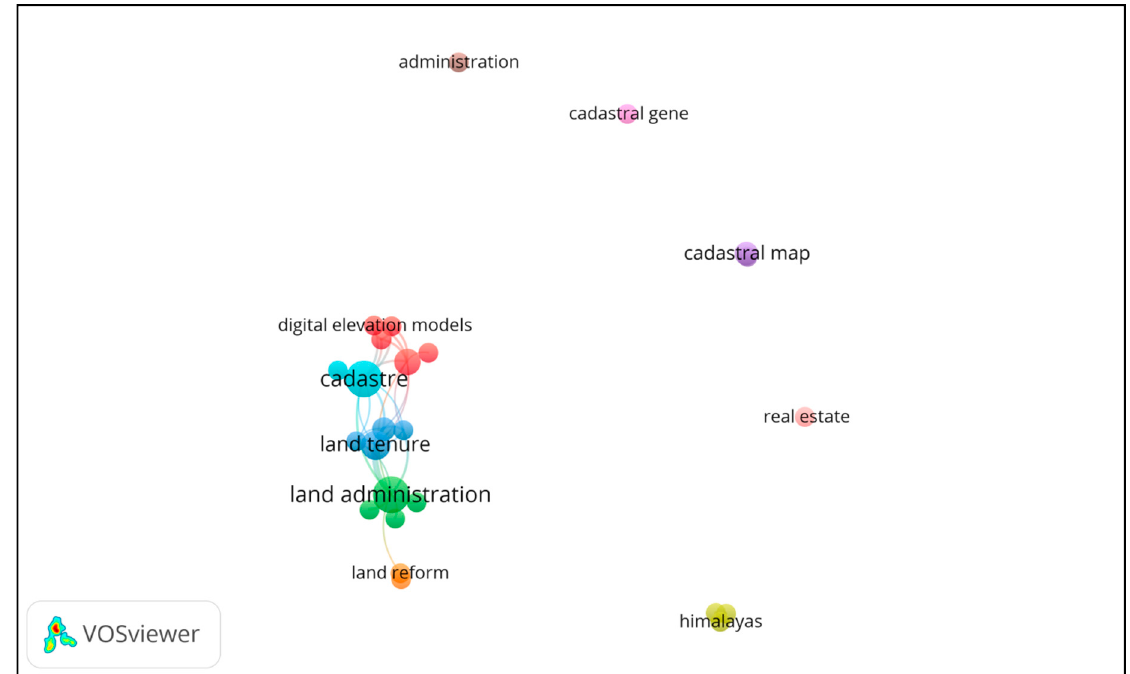
Figure 3. Keyword network map 1987–2001.